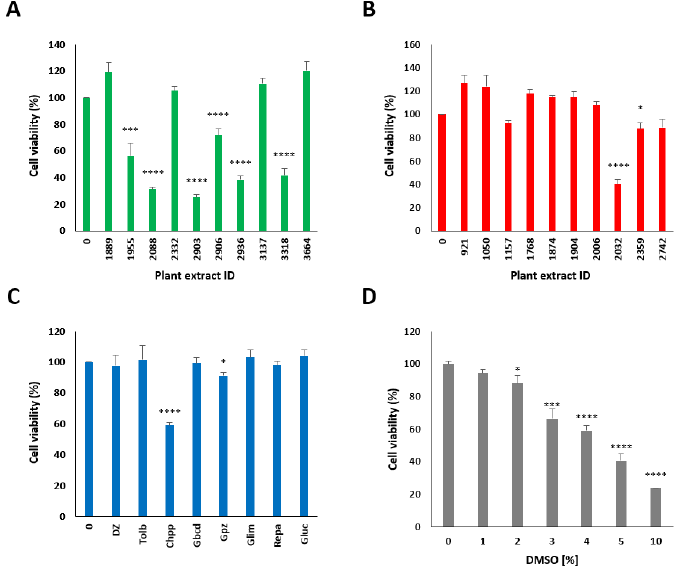
Figure A2. Cell viability of MIN6 pancreatic β cells determined by the resazurin assay tested at a